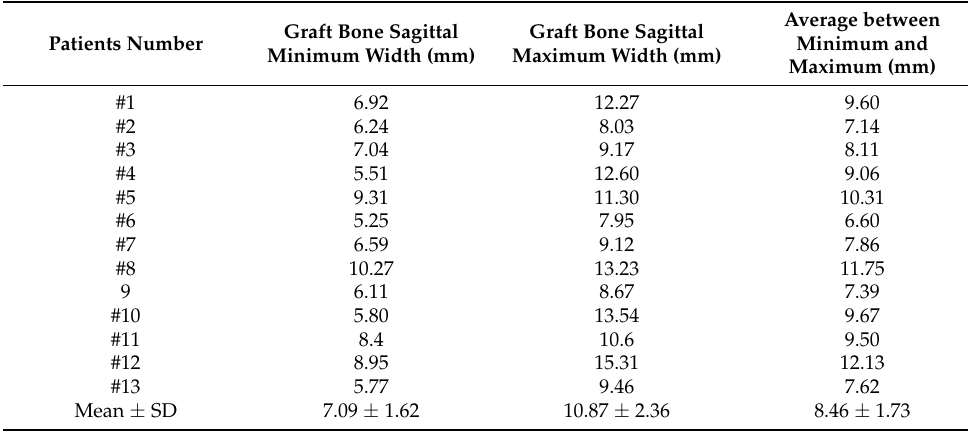
Table 4. Graft bone sagittal minimum and maximum width (mm).